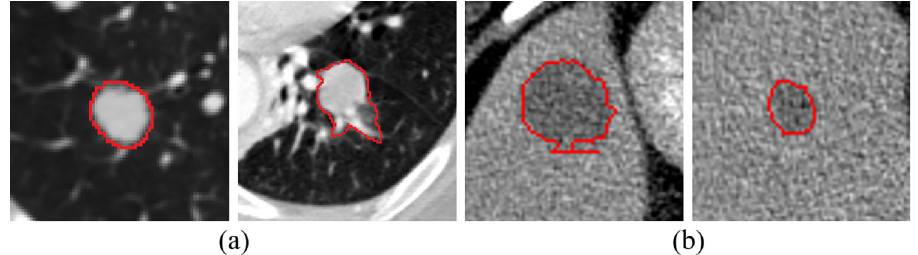
Fig 15. The images of lung nodules and liver tumors. (a) images of lung nodules. (b) Liver tumor